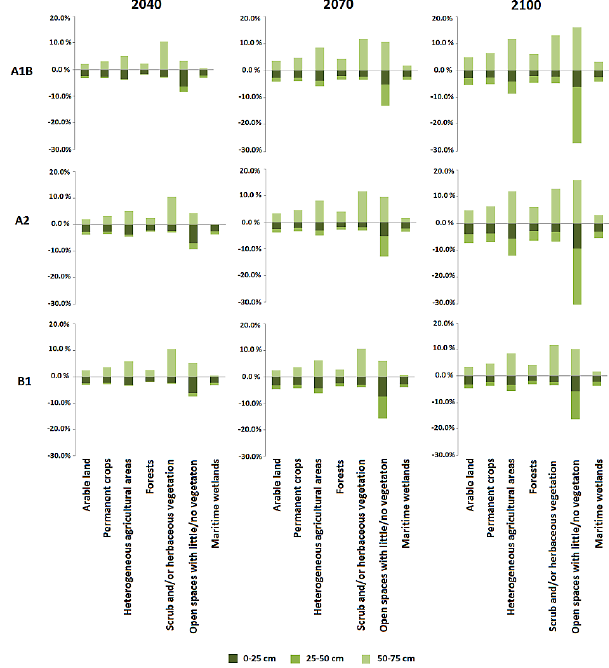
Fig. 7. Soil organic C stocks in climate change SRES scenarios in different periods (2040, 2070 and 2100) for each land use at differ- ent soil depths (0–25, 25–50,